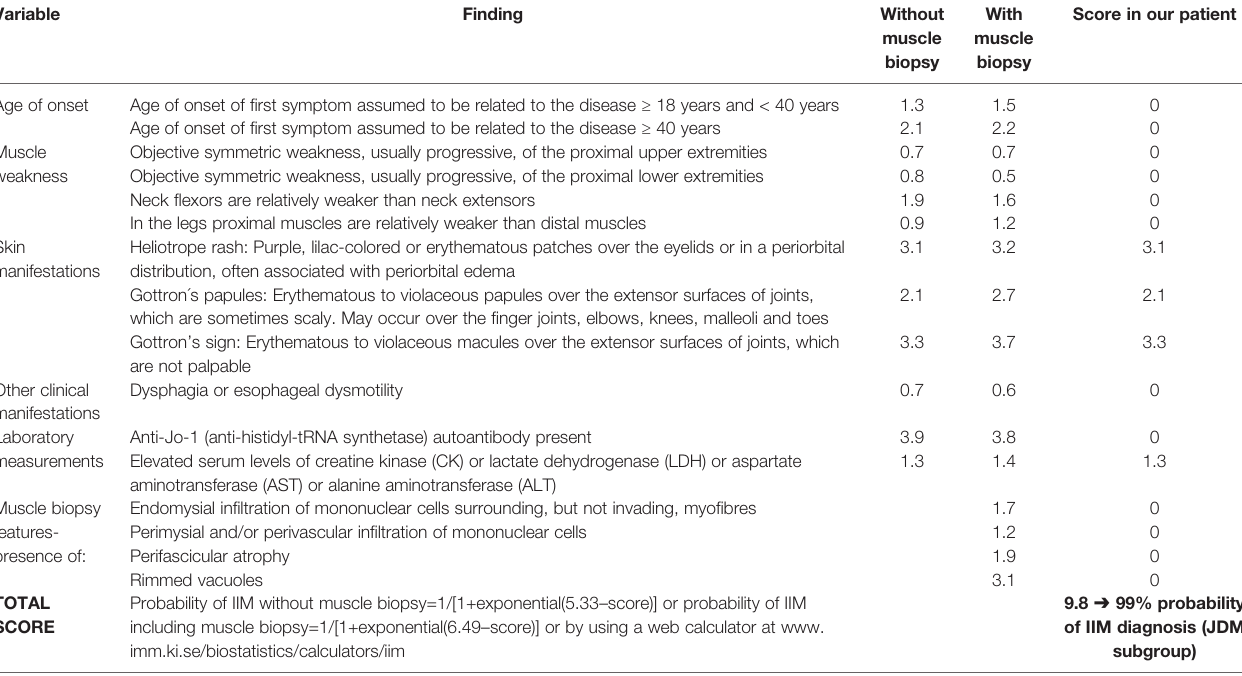
TABLE 2 | EULAR/ACR classi fi cation criteria table for adult and juvenile idiopathic in fl ammatory myopathies and their major subgroups (2) and score in our patient. Variable Finding Without